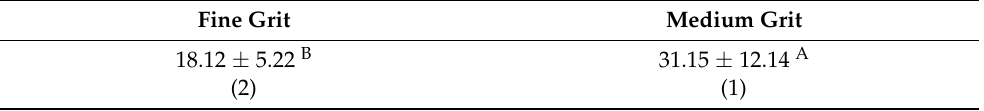
(N: newton). Table 3. Means and standard deviations (mean ± S.D.) of microtensile bond strength (MPa) of each group. The number of premature debonding specimens is presented in parentheses ( n = 20/group).